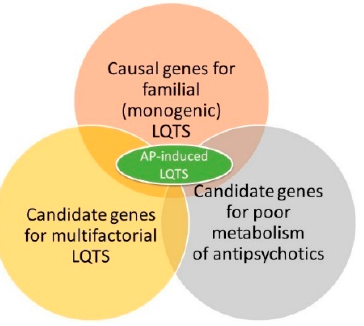
Figure 12. Evaluation of the cumulative risk of multifactorial long QT syndrome provoked or exacerbated by antipsychotics includes carriages of single nucleotide variants of genes predisposing to the development of long QT syndrome (LQTS) and carriages of single nucleotide variants of antipsychotic metabolism genes.